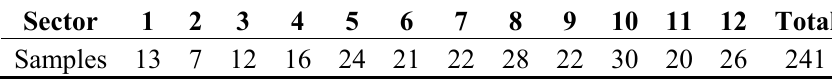
Figure 5. Average wind speed based on satellite SAR ( left ) and modified PARK wake model results ( right ) at 10 m height for the Horns Rev wind farm area for winds from Sector 2 ( a ) and Sector 3 ( b ). The color bar indicates wind speed in m·s − 1 . Table 3. Number of Envisat ASAR samples available per wind directional bin at Horns